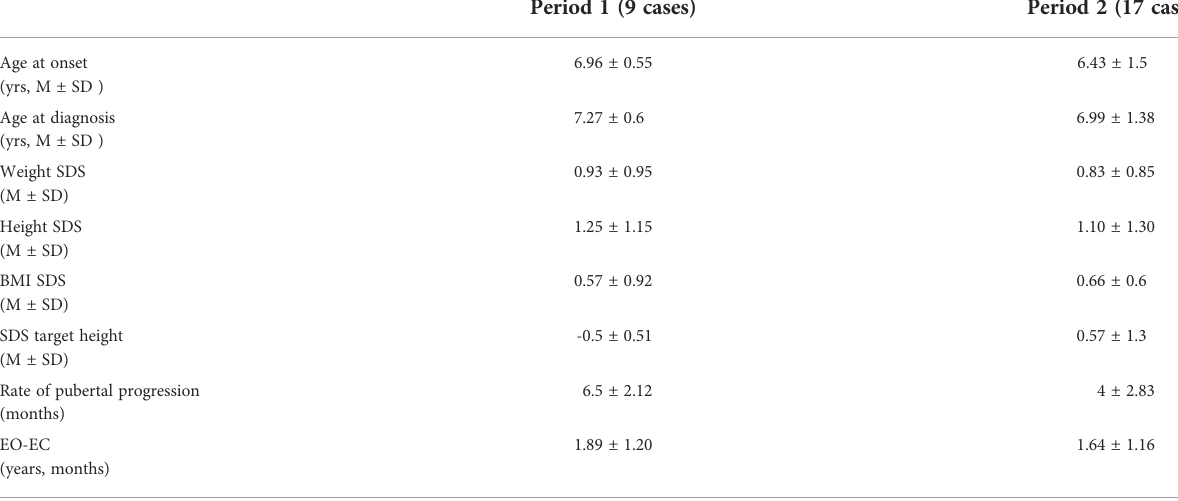
TABLE 2 Auxological data at diagnosis and rate of pubertal progression in girls with CPP subdivided by observation